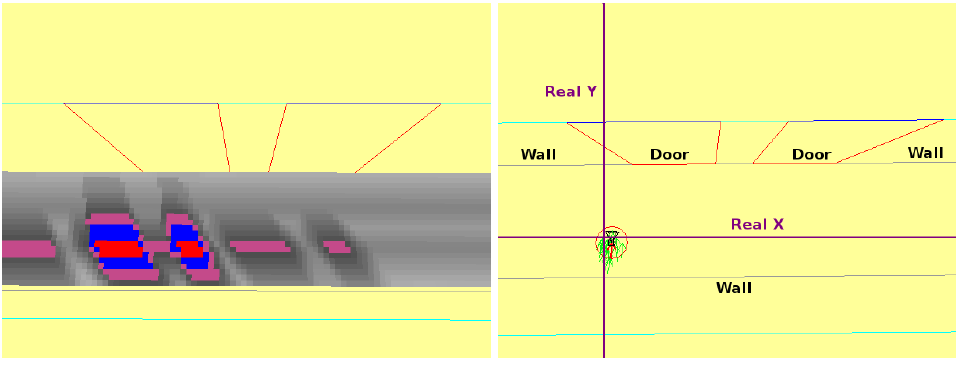
Figure 28. Health values for any theta (left) and estimated position (right) calculated with visual